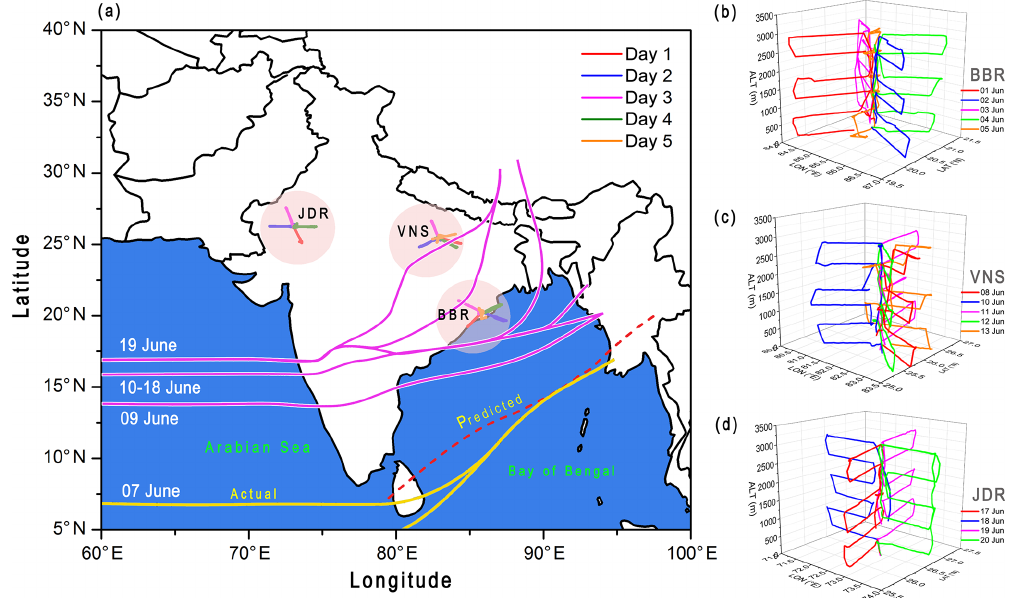
Figure 2. (a) The onset (actual) of the SW monsoon at different parts of India, shown by the yellow and pink (solid) lines. The horizontal and vertical flight paths during each of the flights at (b) Bhubaneswar (BBR), (c) Varanasi (VNS) and (d) Jodhpur